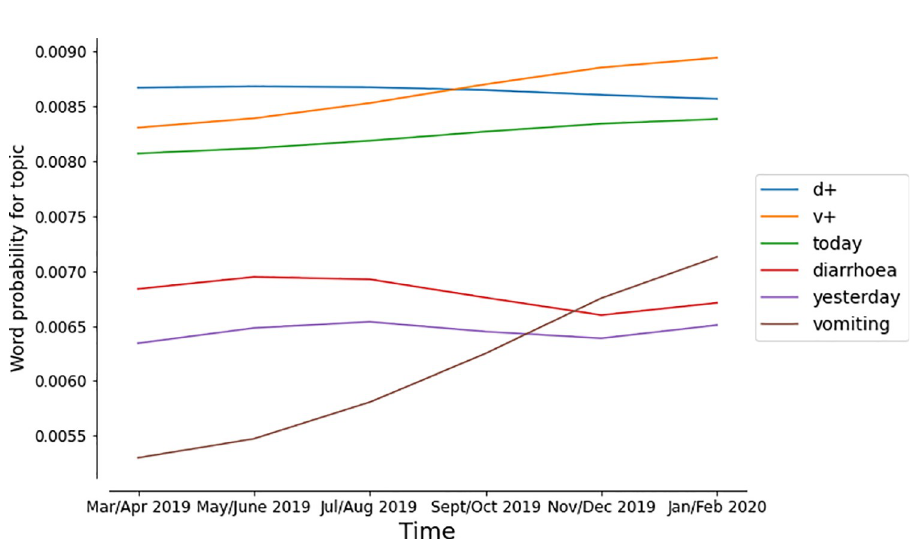
Fig 7. Dynamic topic modelling. The evolution of token-weighting within the gastroenteric topic showed increasing weighting for vomiting-related